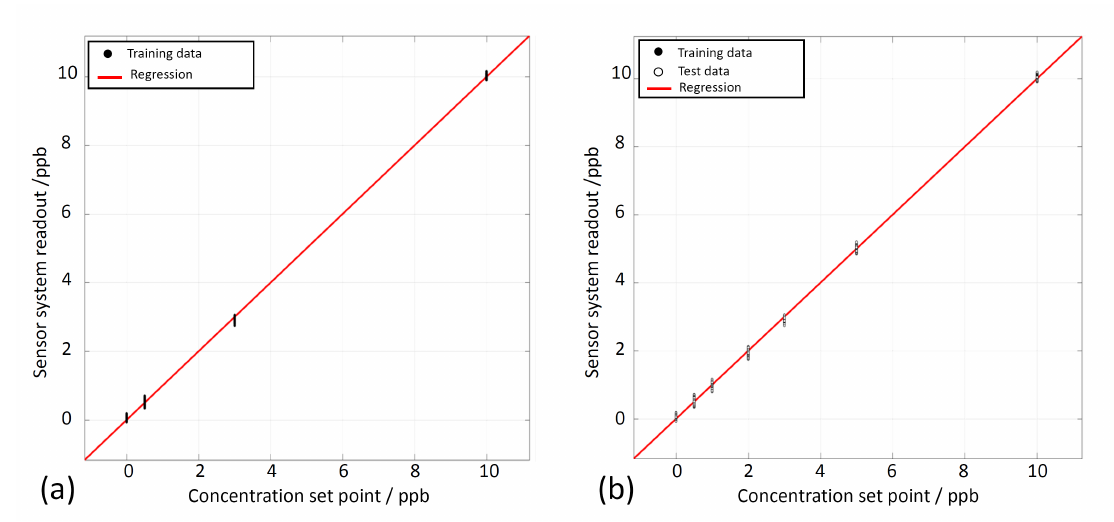
Figure 1. Quantification of benzene in zero air using feature extraction and PLSR. (a) Only training data. (b) Training and test data.